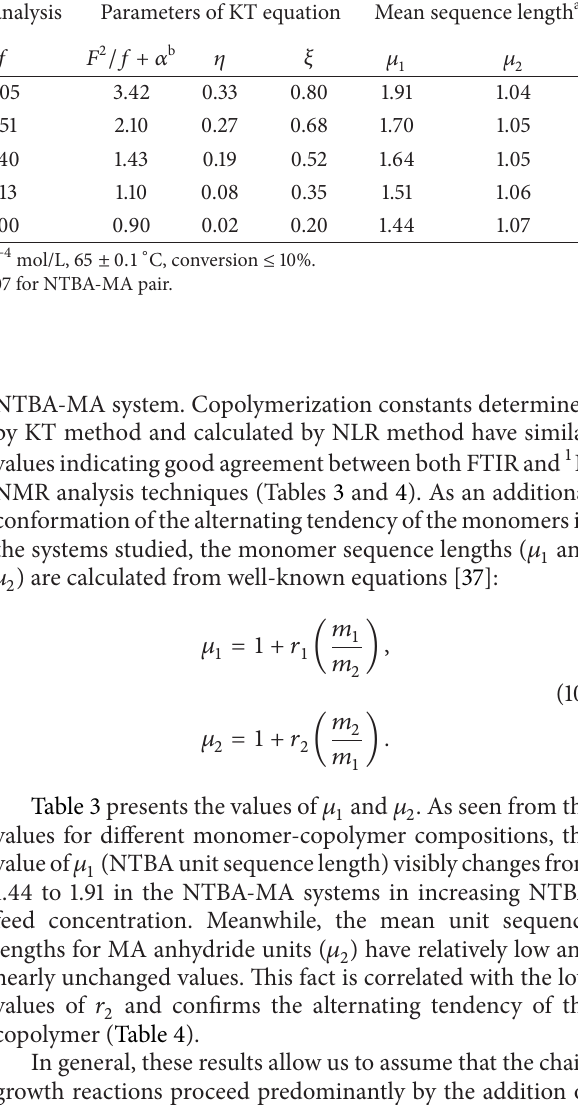
Table 3: Kelen-T ̈ ud ̈ os (KT) parameters for determination of monomer reactivity ratios for NTBA-MA pair. Monomer ratio By 1 H NMR Parameters of KT equation By N analysis Parameters of KT equation Mean sequence length a NTBA/MA